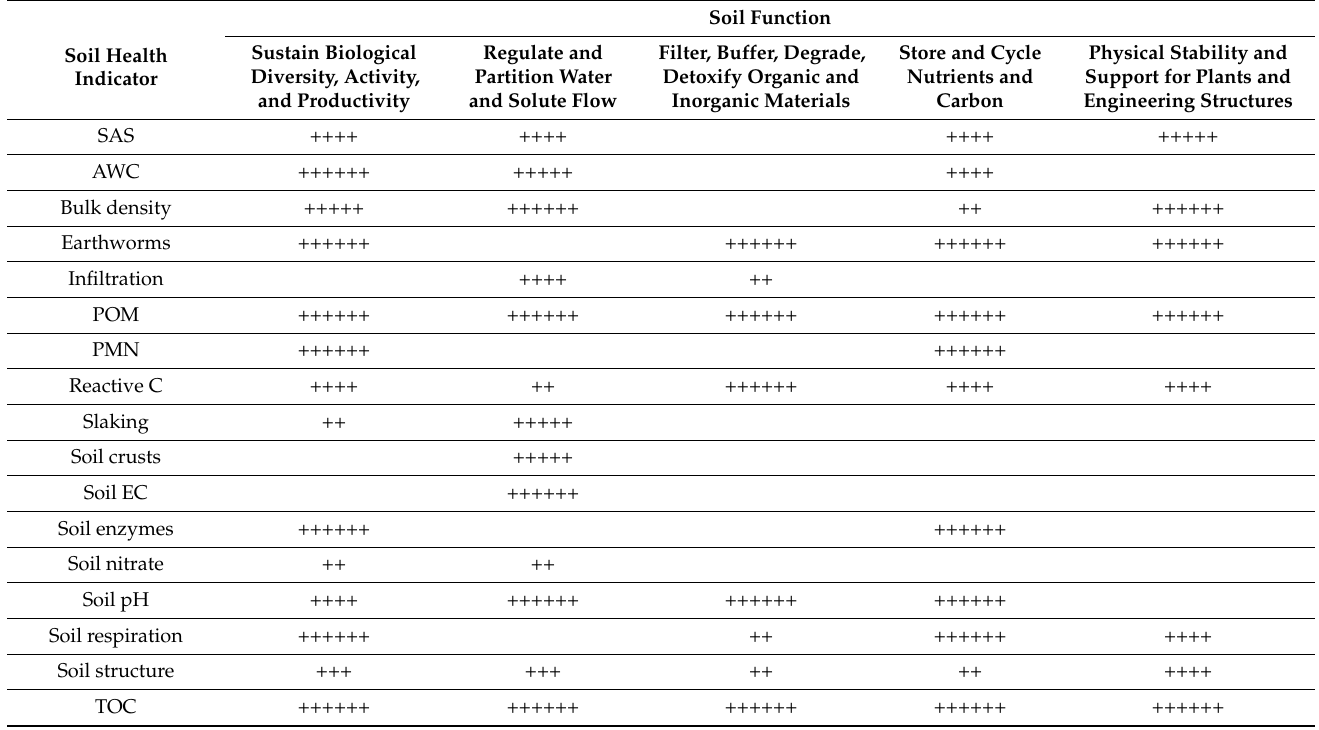
Table 1. The relevance of a soil health indicator to soil functions as shown via number of crosses. The reliability of the relevance increases with an increasing number of crosses